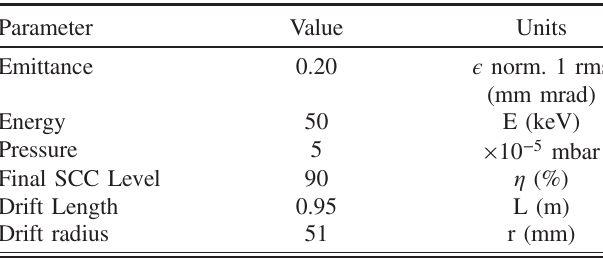
TABLE II. Simulation input parameters in the beam line including a solenoid magnet.